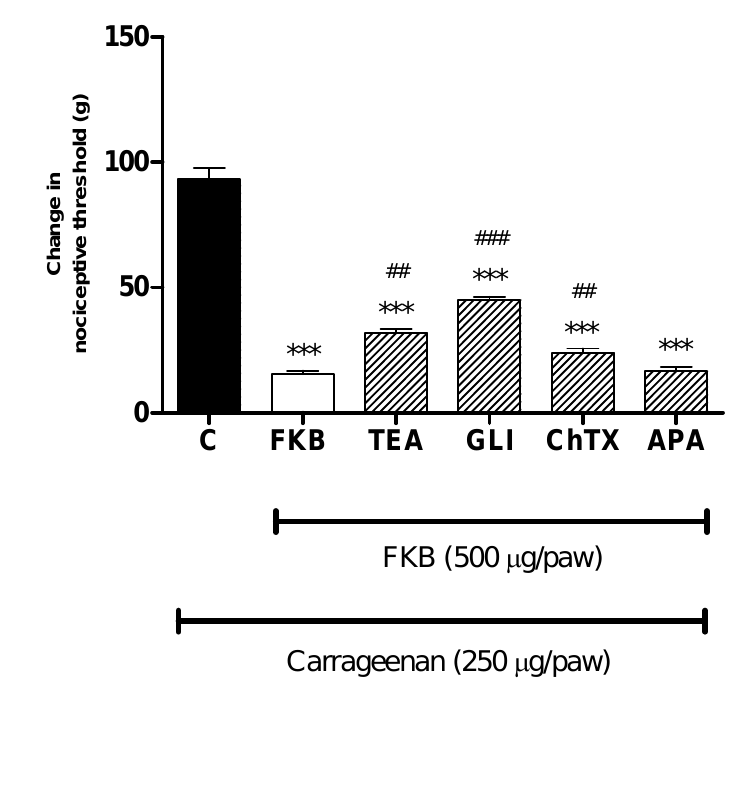
Figure 4. The effect of intraplantar administration of K + channel blockers on the peripheral antinociceptive effect of FKB against carrageenan-induced hyperalgesia test in rats. Tetraethylammonium (TEA; 200 µg/paw), glibenclamide (GLI; 200 µg/paw), charybdotoxin (ChTX; 3 µg/paw) and apamin (APA; 3 µg/paw) were administered 15 min before FKB (500 µg/paw). Each column represents the mean ± S.E.M. ( n = 6). *** p < 0.001 when compared with the control (C) group; ## p < 0.01, ### p < 0.001 when compared with the FKB group (one-way ANOVA followed by Dunnett’s post hoc).